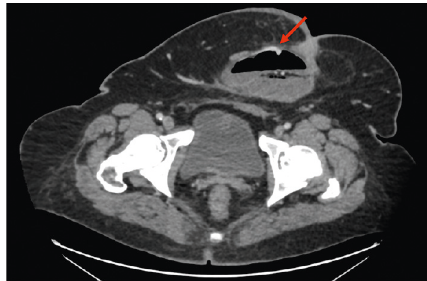
Figure 1: CT angiography showing a varix in the sac of the umbilical hernia.